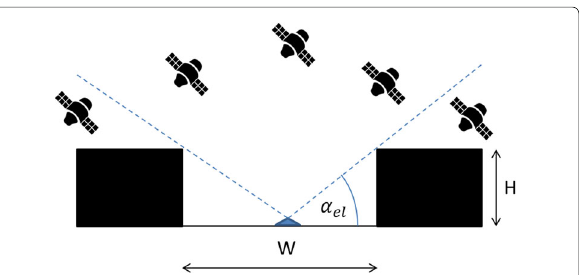
Fig. 18 RTK LoS under urban conditions, modeled by adjusting elevationcutoffangle α al tothestreetgeometry:width W andheight